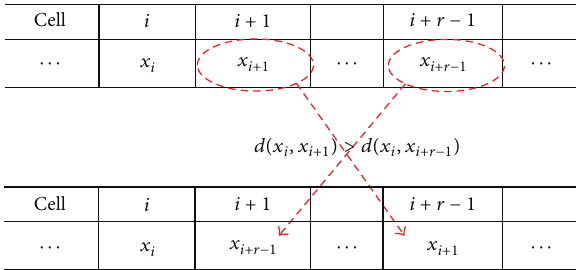
Figure 1: Data items 𝑥 𝑖 , 𝑥 𝑖+1 , and 𝑥 𝑖+𝑟−1 are at cells 𝑐 𝑖 , 𝑐 𝑖+1 , and 𝑐 𝑖+𝑟−1 , respectively. The transition rule 𝜙 𝑟 applied to 𝑐 𝑖 exchanges 𝑥 𝑖+1 and